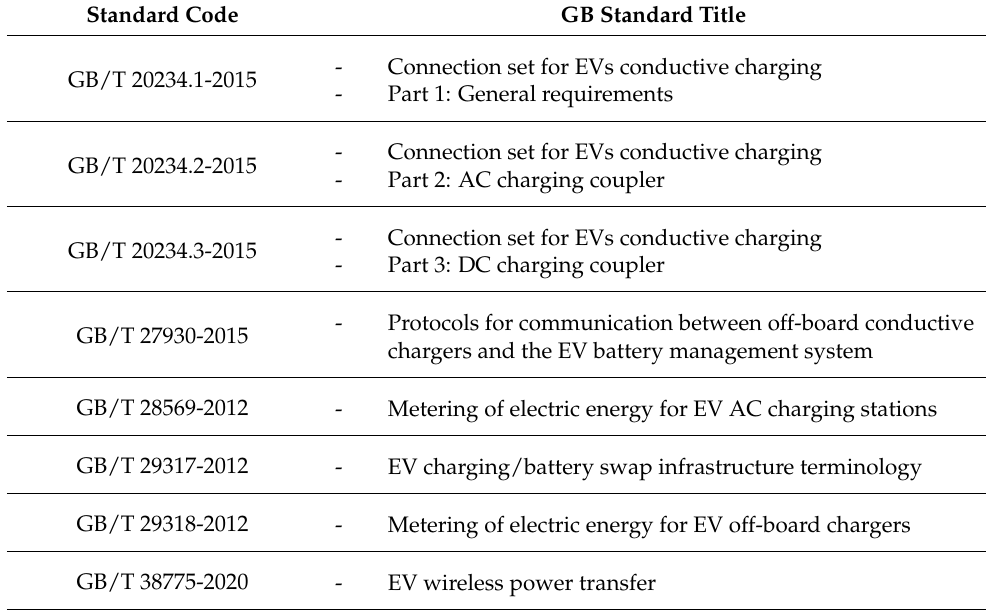
Table 4. Overview of GB/T standards for EV charging